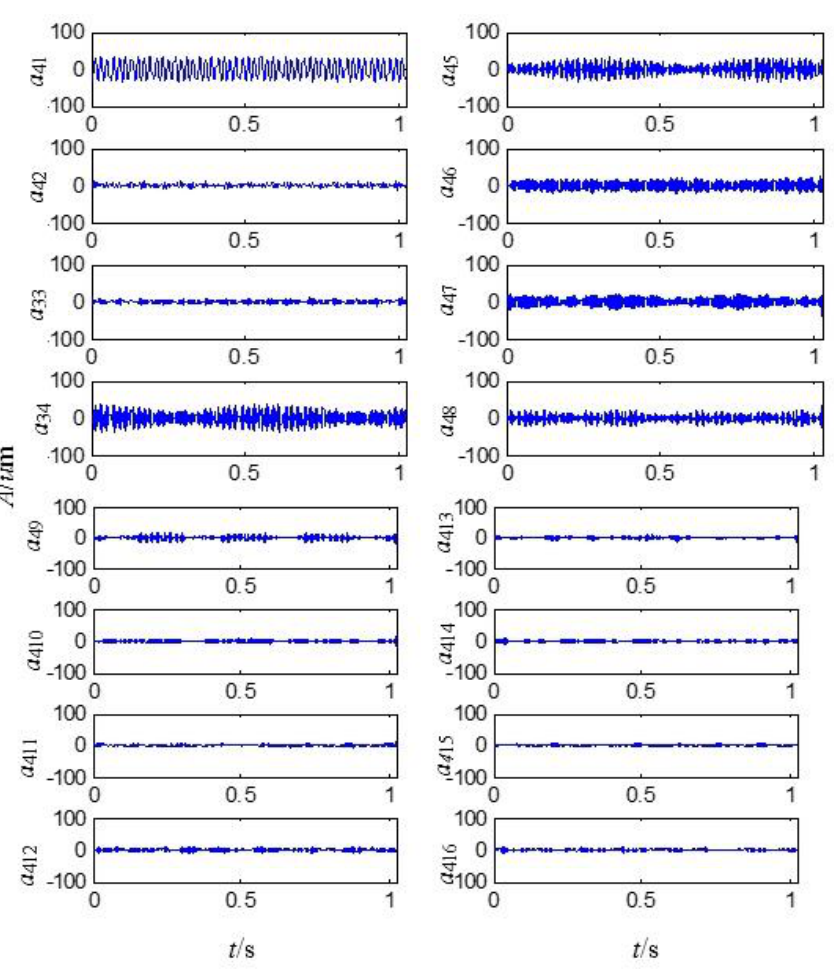
Figure 11. Signals analyzed by second generation wavelet package in level 4.